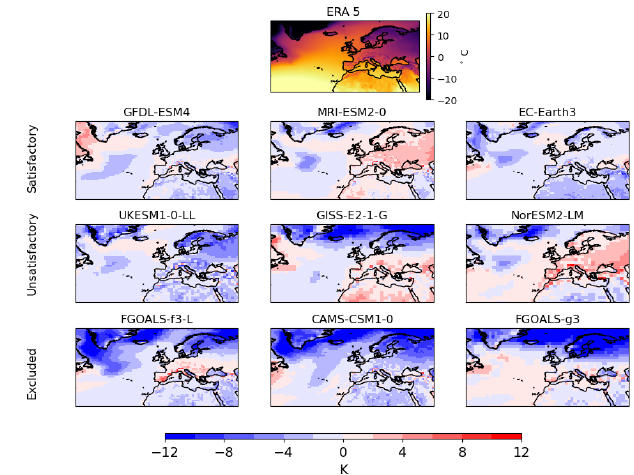
Figure A5. Model large-scale temperature bias for the large-scale domain. Seasonal DJF average calculated for a 20-year climatology (1995–2014).